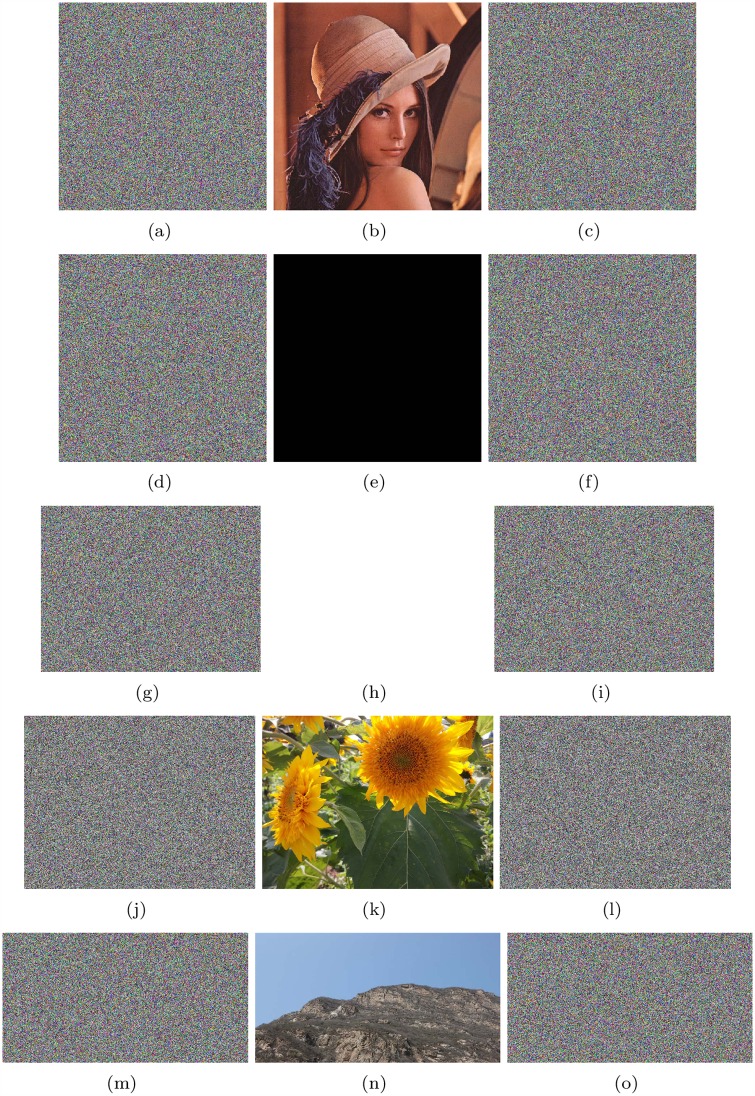
Sensitivity to cipher image test results of Lena, all-zero image, white, flower and mountain.(a) cipher of Lena; (b) decrypted image of Lena’s cipher; (c) decrypted image of Lena’s cipher with a pixel changed; (d) cipher of all-zero; (e) decrypted image of all-zero’s cipher; (f) decrypted image of all-zero’s cipher with a pixel changed; (g) cipher of white; (h) decrypted image of white’s cipher; (i) decrypted image of white’s cipher with a pixel changed; (j) cipher of flower; (k) decrypted image of flower’s cipher; (l) decrypted image of flower’s cipher with a pixel changed; (m) cipher of mountain; (n) decrypted image of mountain’s cipher; (o) decrypted image of mountain’s cipher with a pixel changed.